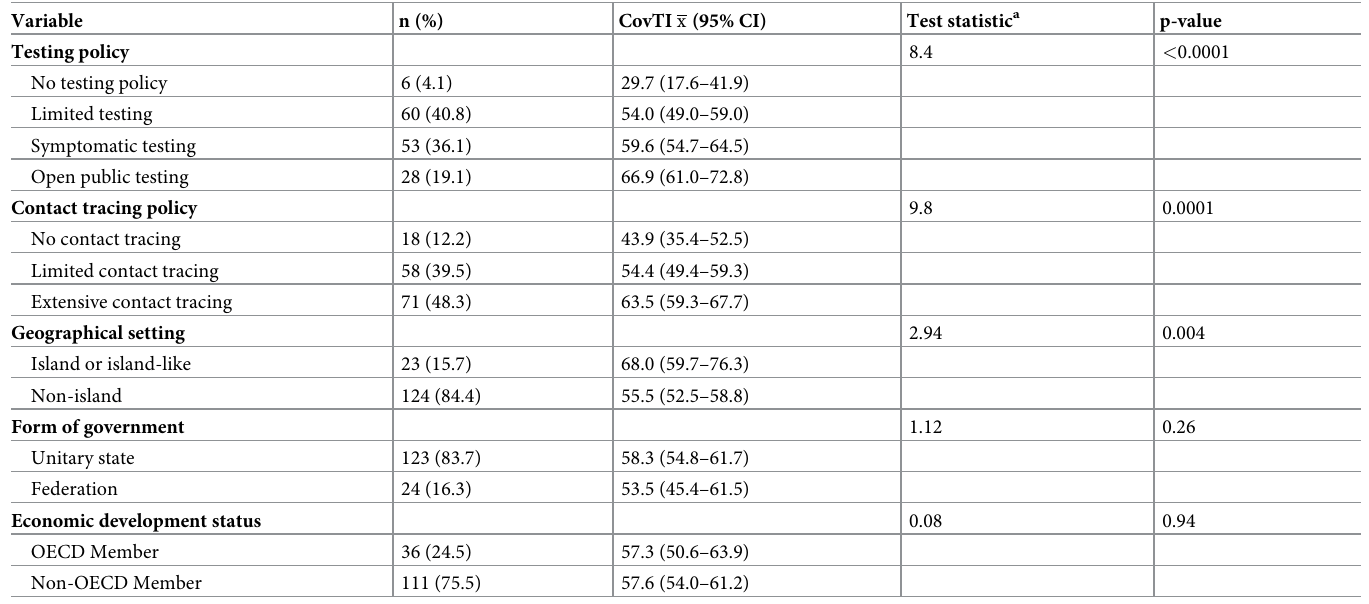
a t-statistic from two-way two-sample t-test with equal variance or F-statistic from one-way